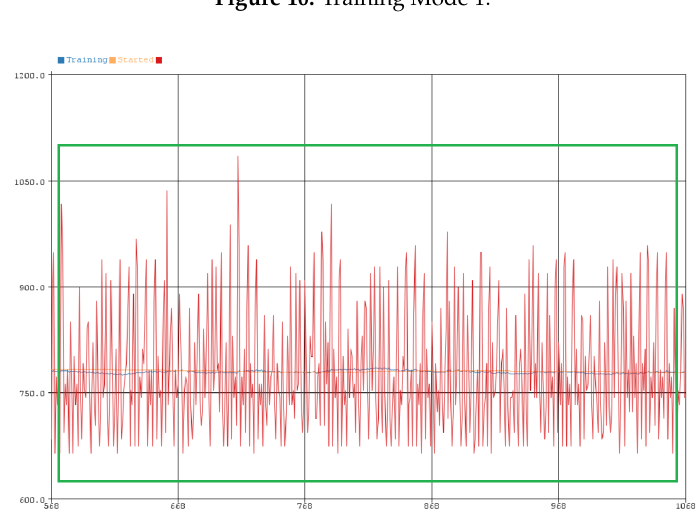
Figure 10. Training Mode 1.